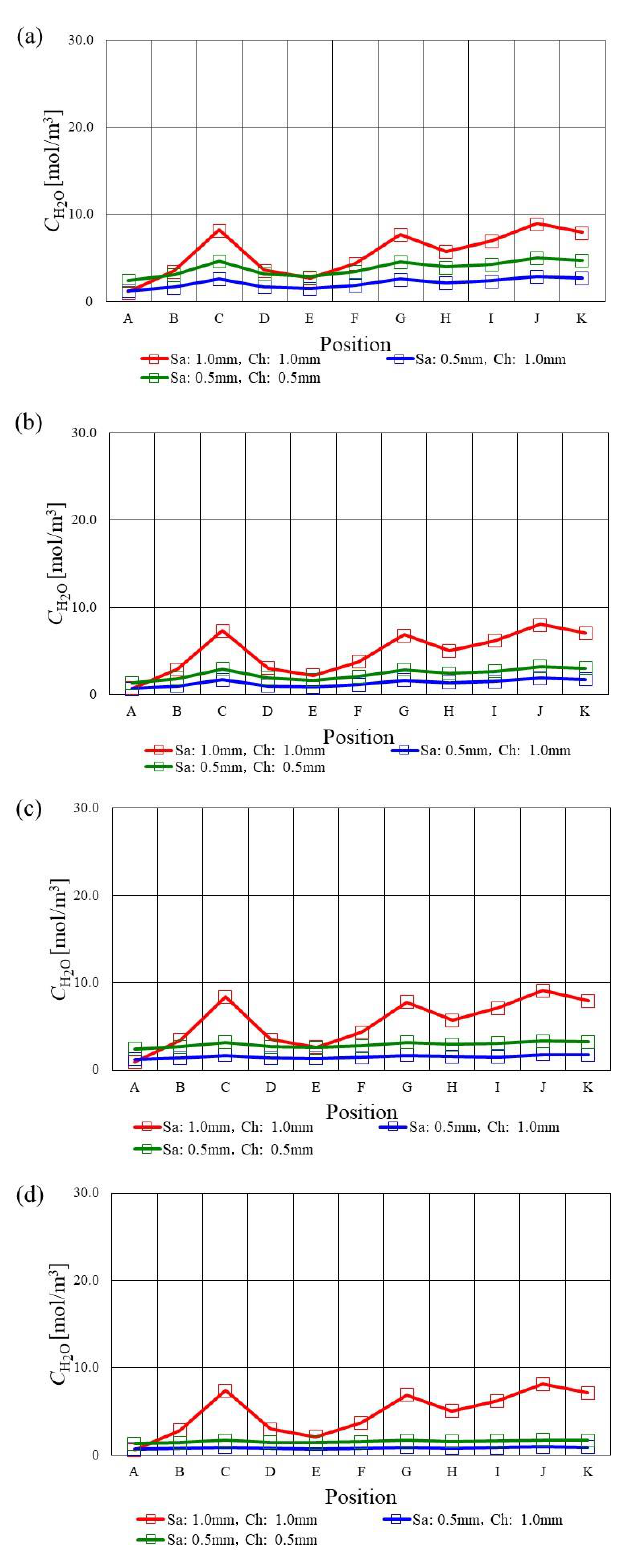
Figure 10. Molar concentration of H 2 O along with the gas channel on the interface between PEM and catalyst layer at the cathode among various s.t. at T ini = 373 K. ( a ) A80%RH/C80%RH, ( b ) A80%RH/C40%RH, ( c ) A40%RH/C80%RH, ( d )